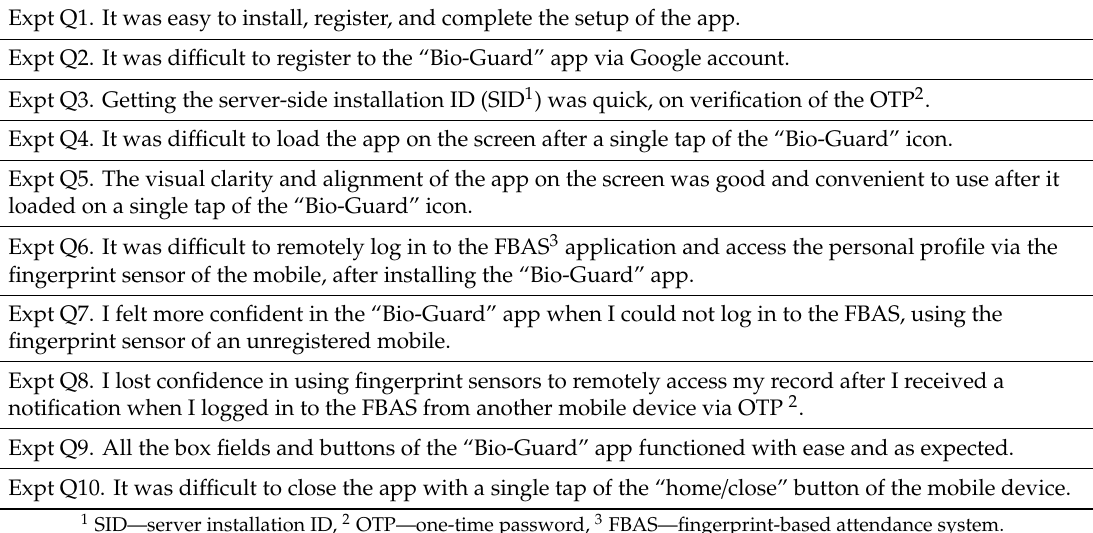
Table 2. Ten experimental questions (Expt Q) prepared on the format of the SUS scale but presented in statement format for easy